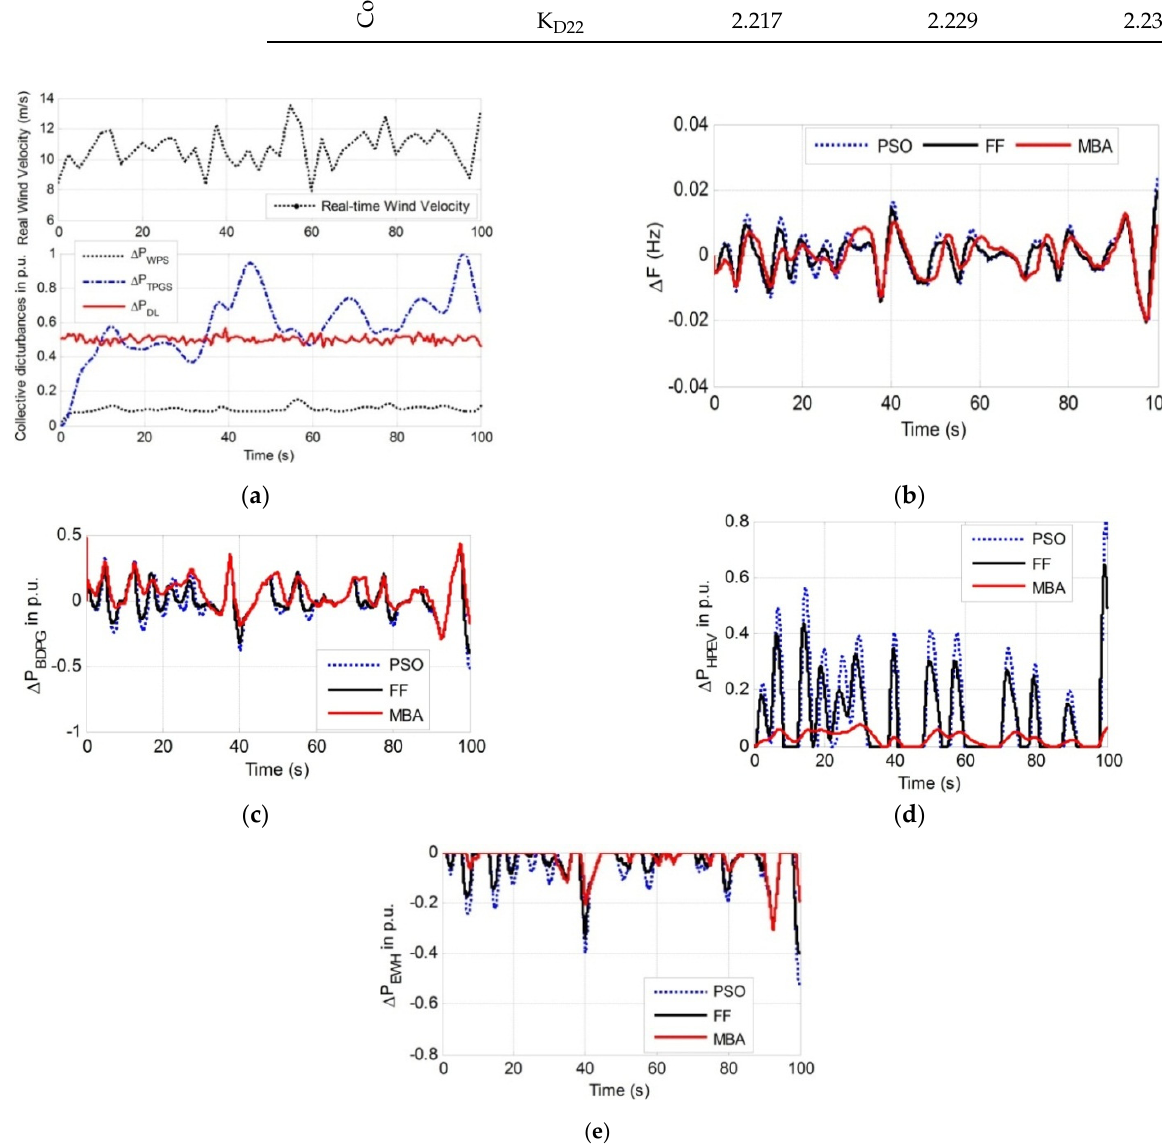
Figure 6. Comparison of the dynamic response when PI − (1 + DD) controller is optimized with PSO, FF with MBA ( a ) Real-time data based multiple random disturbances ( b ) frequency deviation, ( c ) power contribution of BDPG, ( d ) power contribution of HPEV, and ( e ) power output of EWH.